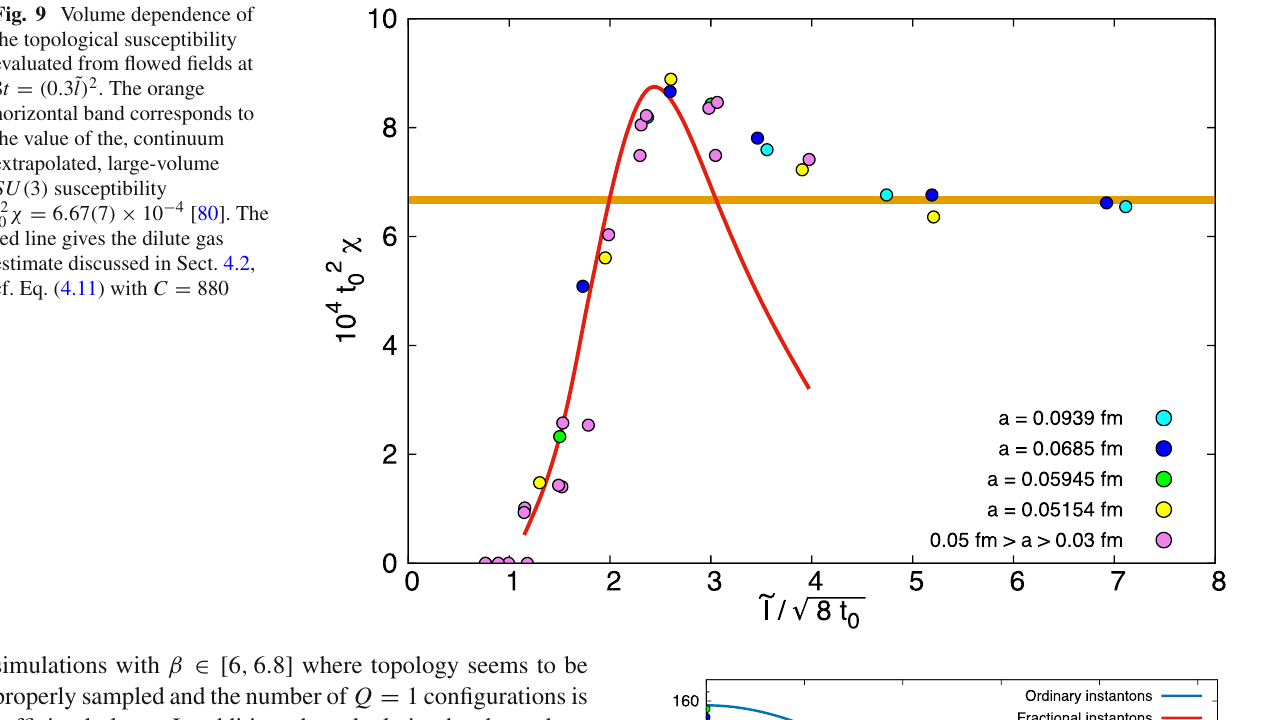
(cid:2) (cid:3) λ ( c ) − λ ( c ) as Q = 1 Q = 0